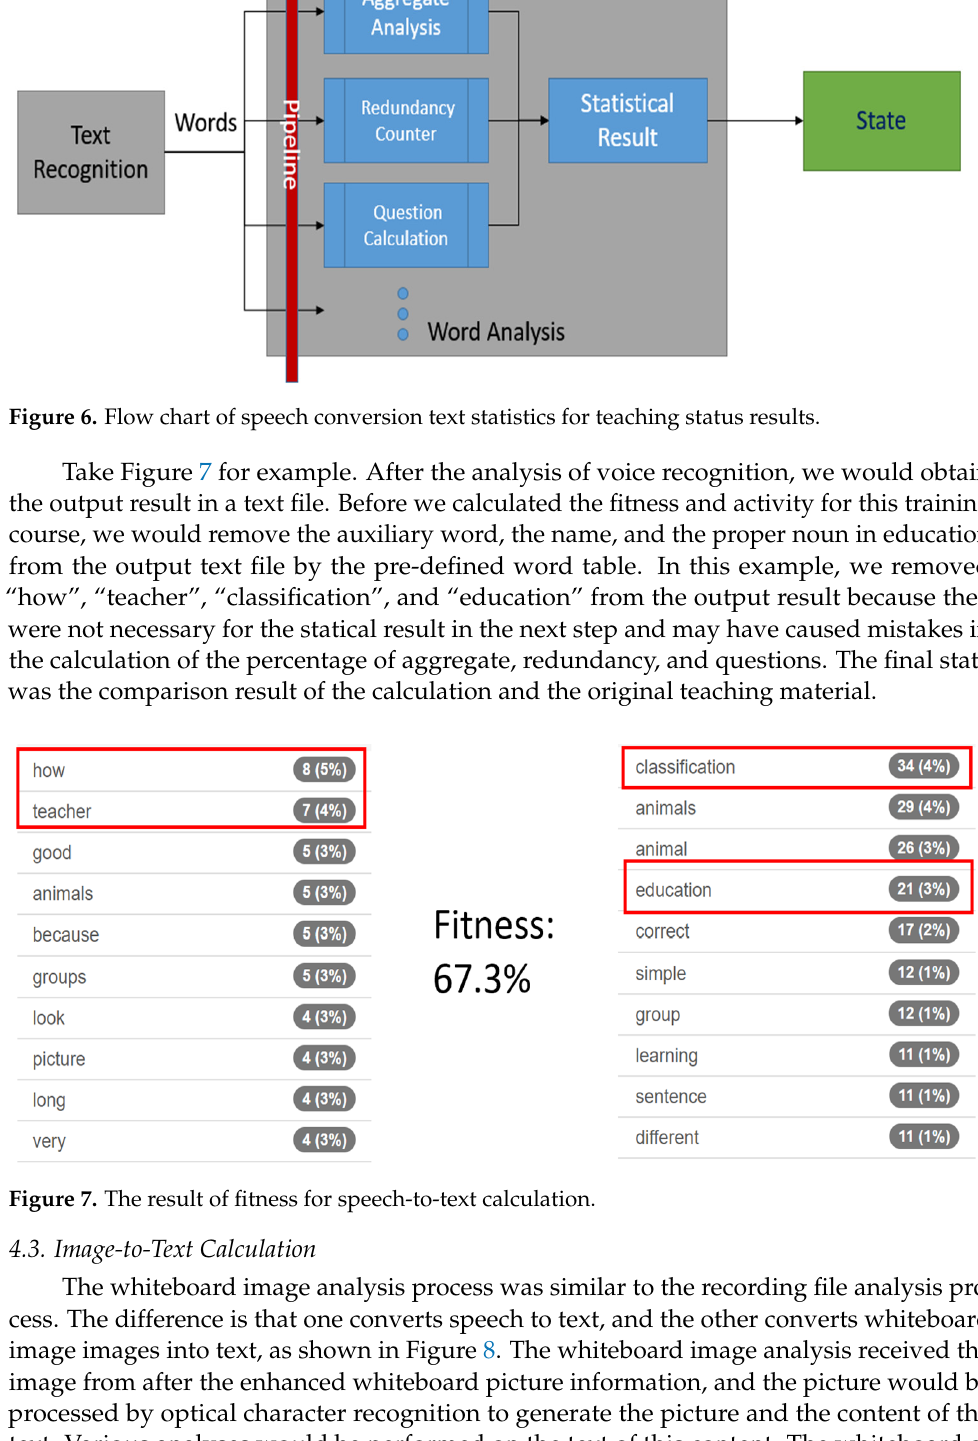
Figure 7. The result of fitness for speech-to-text calculation.